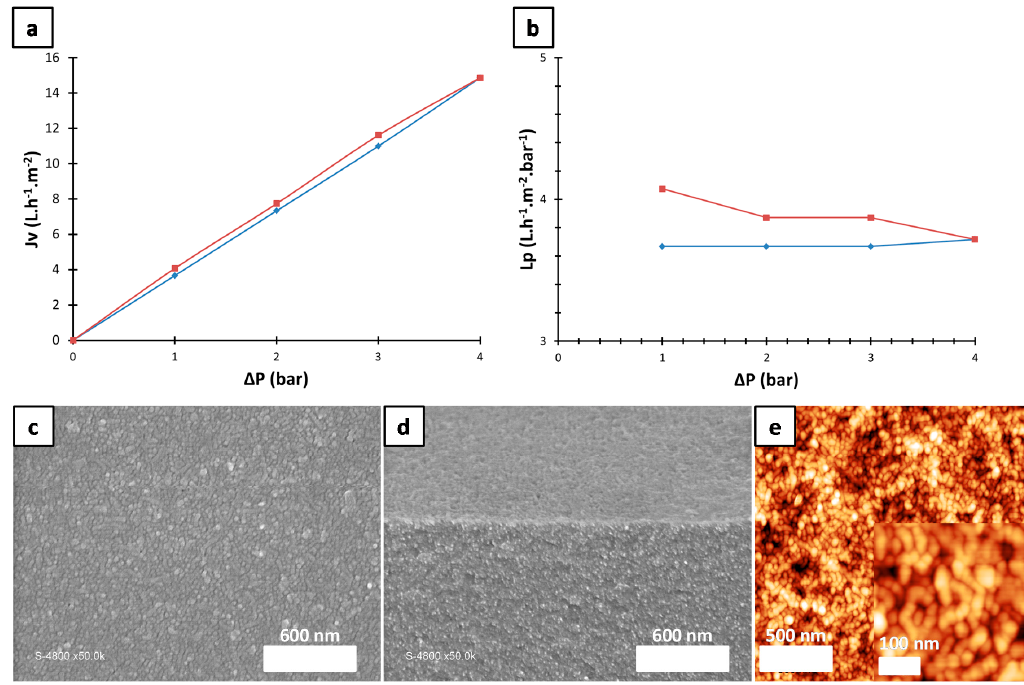
Figure 5. ( a ) Flux of the coated membrane determined by water filtration at different pressures. ( b ) Permeability of the coated membrane determined by Darcy’s law at different pressures (blue indicates increasing pressure and red indicates the decreasing pressure). ( c , d ) SEM image of the top surface ( c ) and cross section ( d ). ( e ) AFM image of the deformed micellar assembly after water permeation.